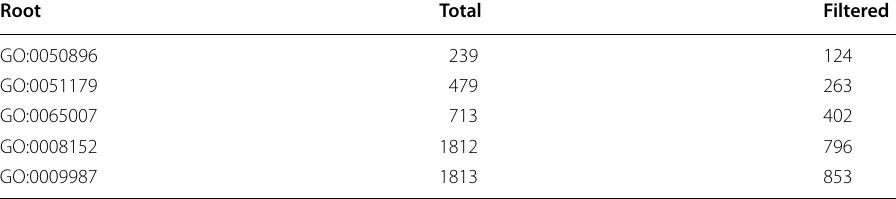
Recall that the extracted features are filtered using the mean SHAP values to select the more important with a cutoff defined by the input constant c